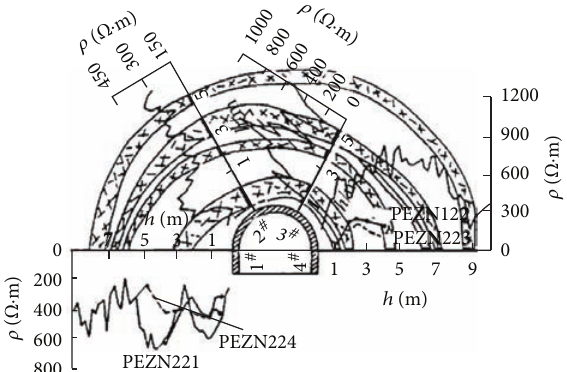
Figure 1: Zonal disintegration of Taimyrskii mine [4].